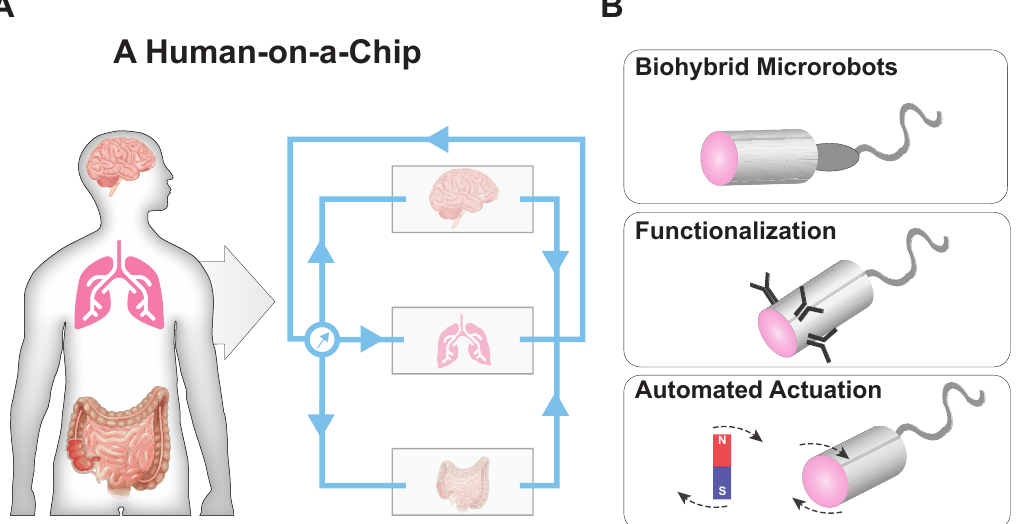
Figure 6. Future directions for microbiorobot drug delivery in organ-on-a-chip systems. ( A ) Plug-and- play human-on-a-chip systems could be customized to monitor systemic e ff ects of drug-laden MBRs, such as changes in the brain, lungs, and gut. ( B ) Using these systems, next generation microbiorobots could be developed to optimize motility, precision, and drug e ffi cacy. Examples of features for customizing microbiorobot would include functionalization with biological components [71]; specific recognition and binding components for targeted delivery [12]; and automated, multiaxis magnetic actuation